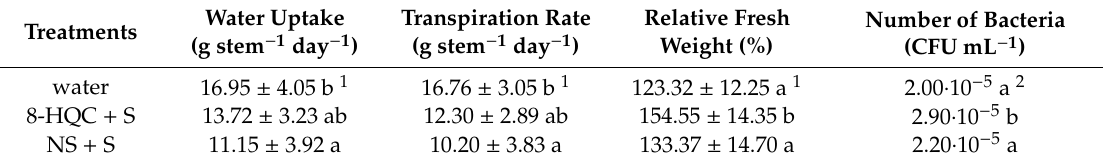
The e ff ect of preservatives on the water balance parameters in cut peony ‘Charles Binder’ flowers.